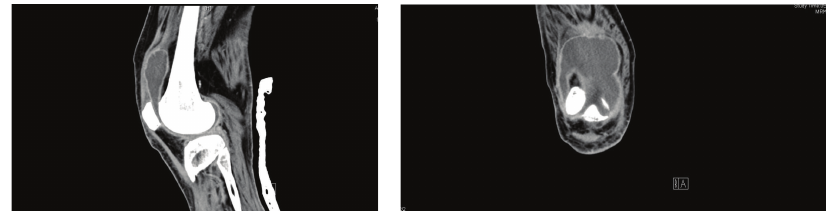
Figure 4: CT scan with moderate to large joint effusion of the (R) knee with associated synovial thickening and